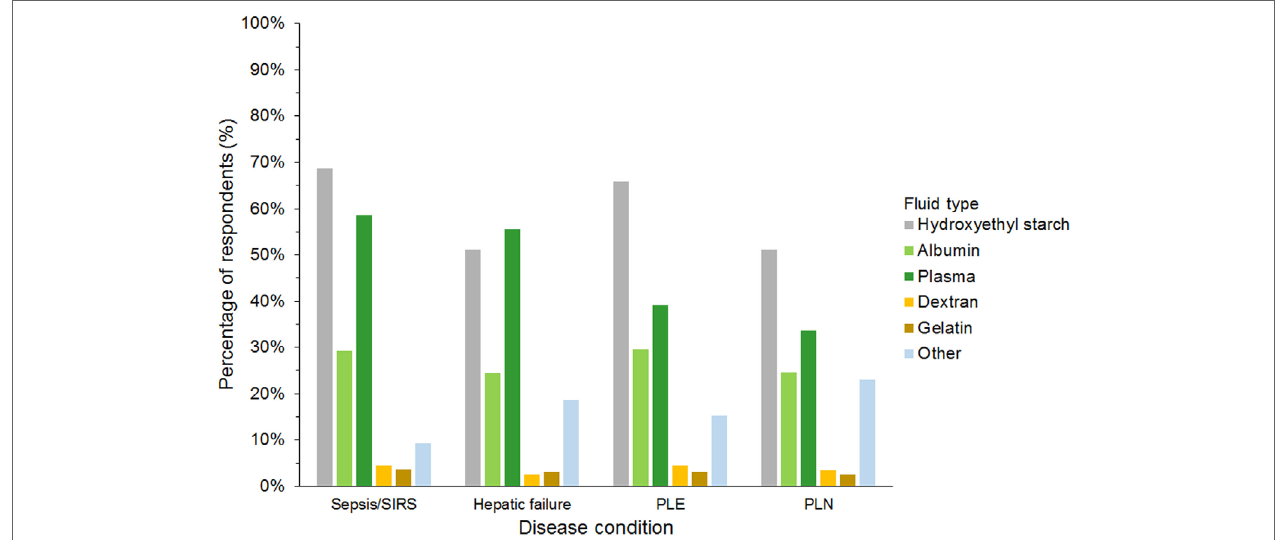
FigUre 6 | Frequency chart showing the type of intravenous solutions used by the 1,134 survey respondents for colloid osmotic support in specific disease conditions. SIRS, systemic inflammatory response syndrome; PLE, protein-losing enteropathy; PLN, protein-losing